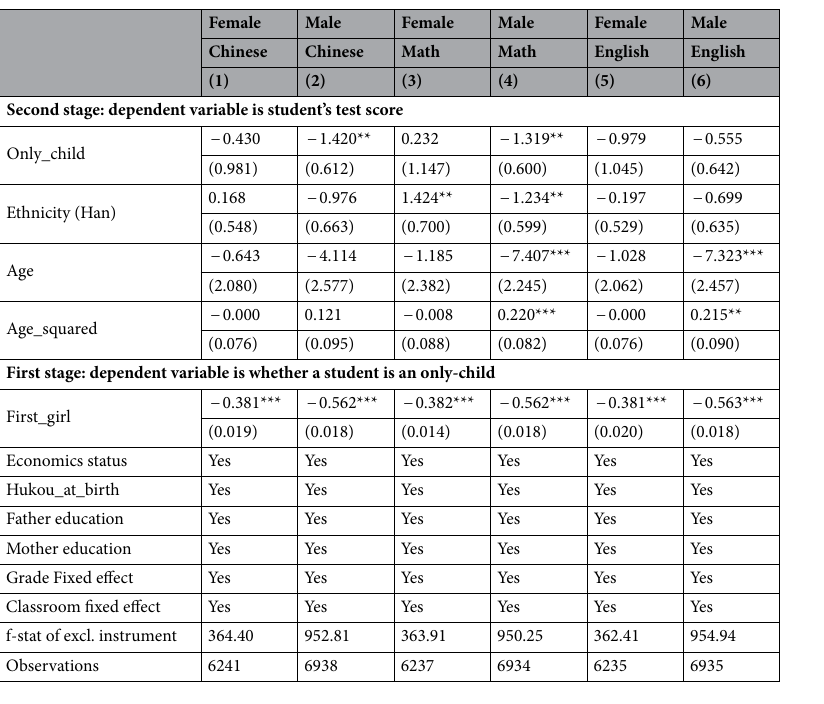
Table 9. The IV estimation of the effect of only-child status on standardized test scores by genders. Notes: Standard errors in parentheses, adjusted for within-classroom clustering. * p < 0.10. ** p < 0.05. *** p <